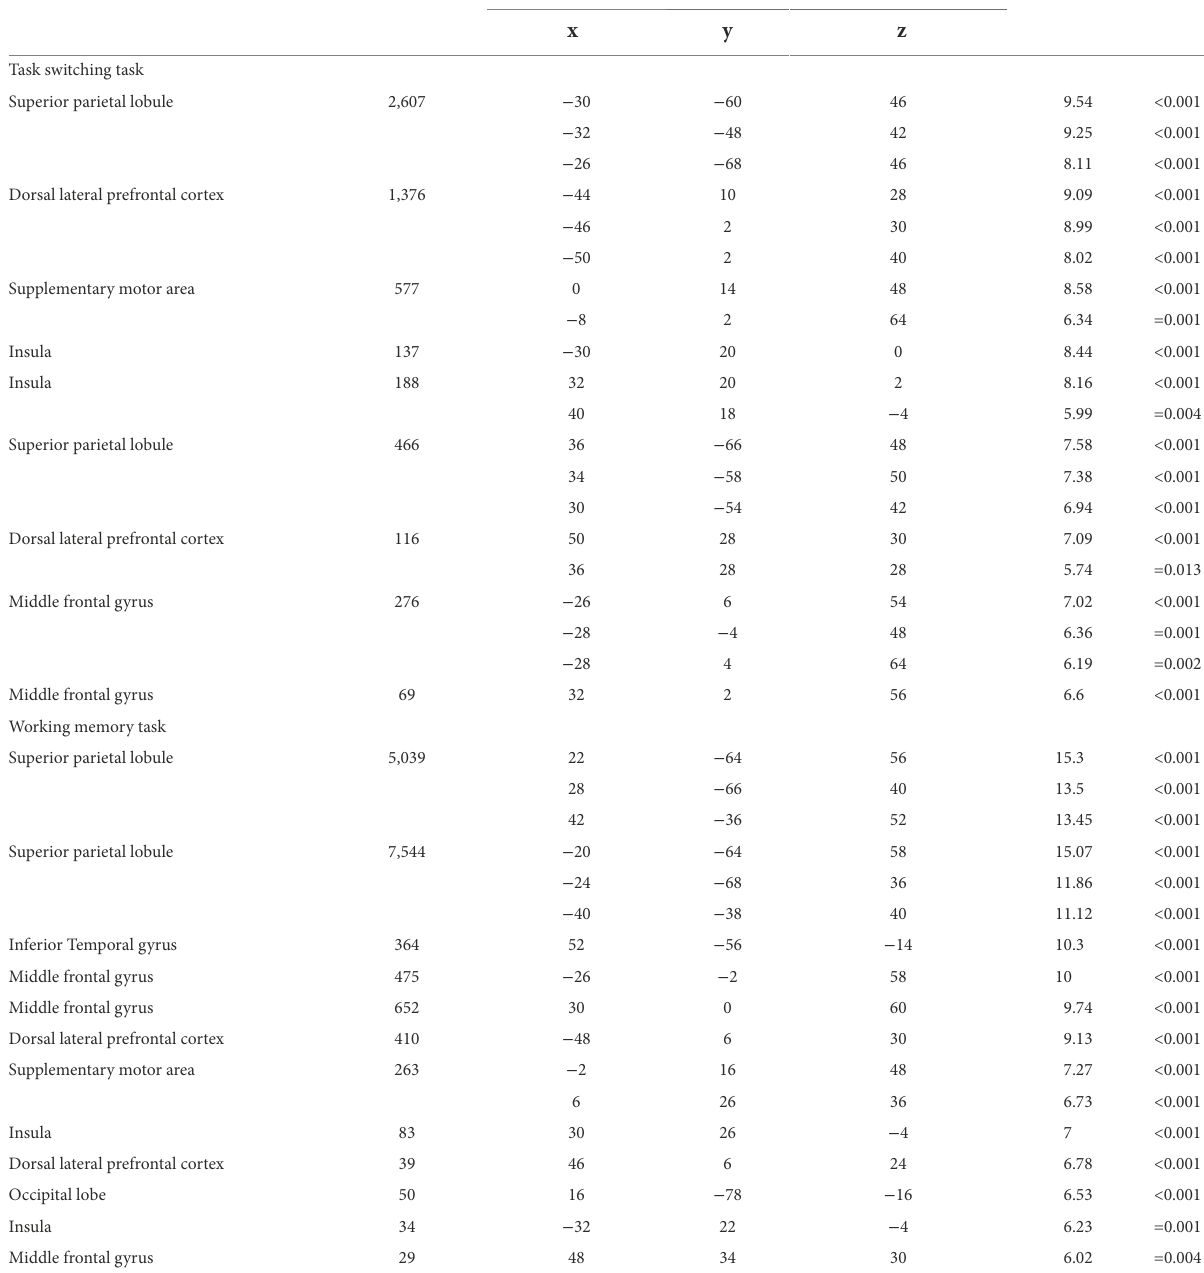
TABLE 1 Brain regions associated with task switching and working memory processes. Region Cluster